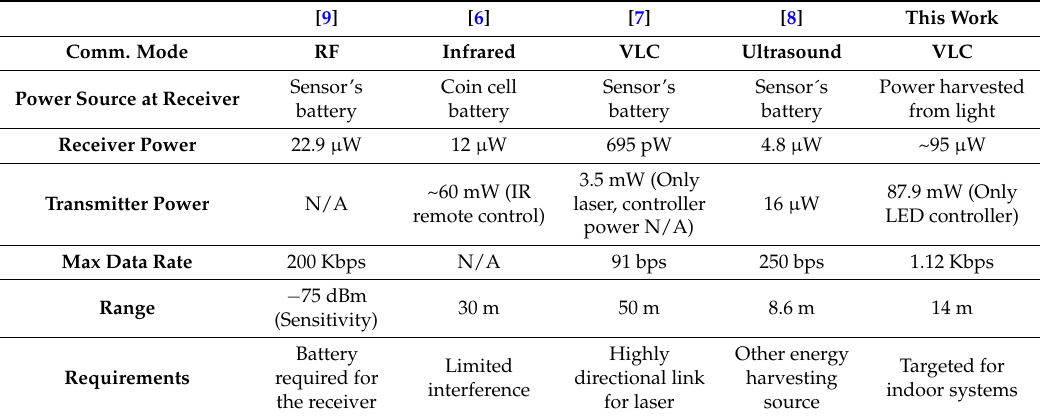
Table 1. An Illustrative Comparison of Different Wake-up Communication Mode